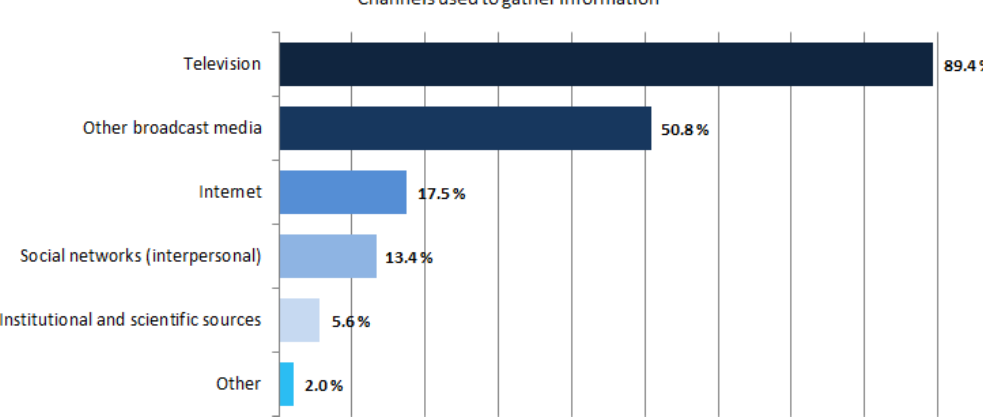
Figure 8. Sources of knowledge on tsunamis: channels and penetration